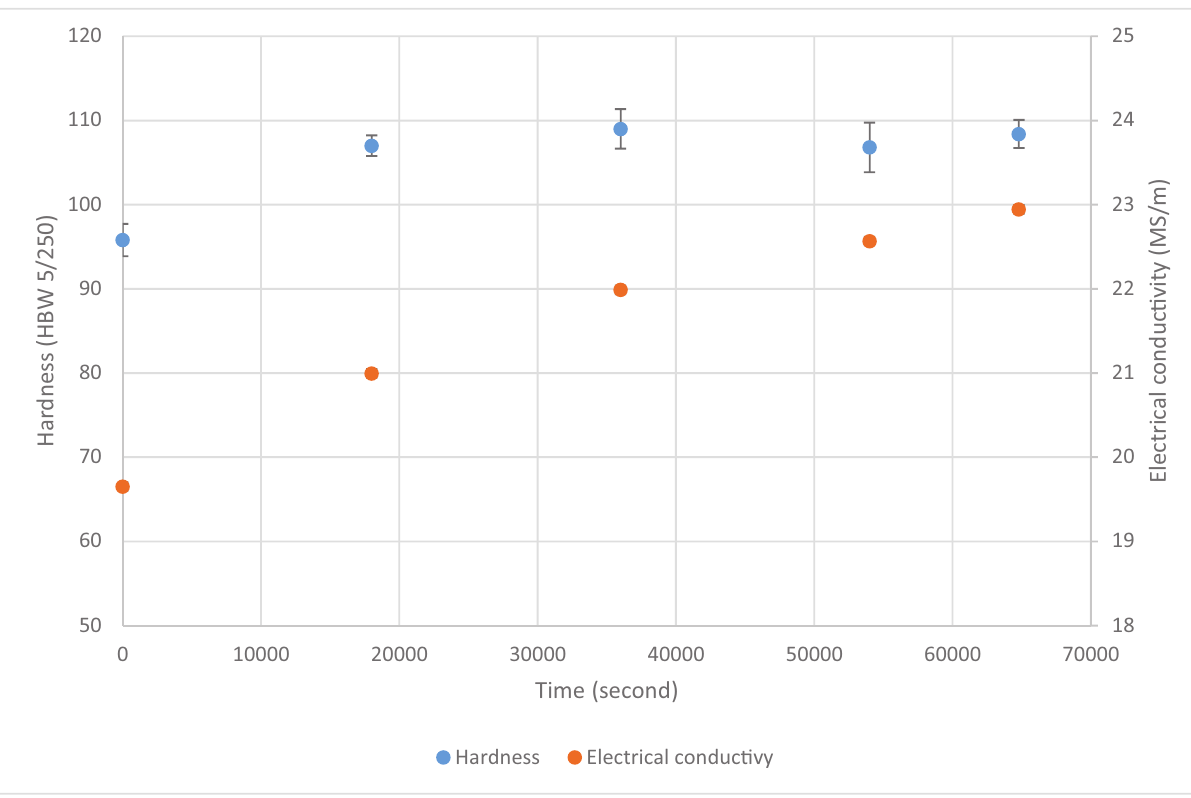
Fig. 6. AlSi5Cu3Mg alloy (cid:1) Change in hardness and electrical conductivity as a function of the isothermal arti fi cial aging at 170 °